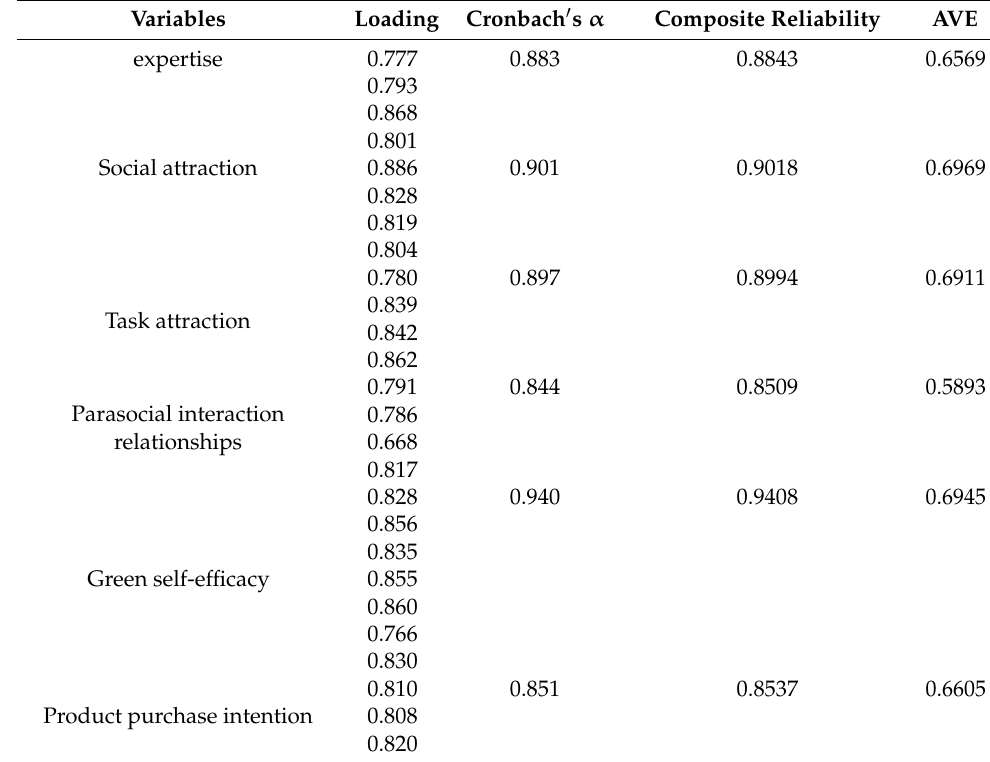
Table 3. Results of the measurement model.